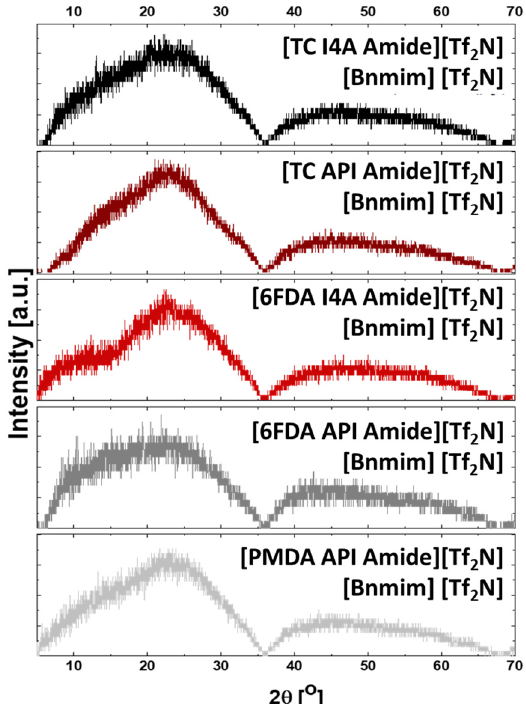
Figure 3. XRD profiles for all five PAA and PAI ionenes impregnated with 2 equivalents (eq.) of [Bnmim][Tf 2